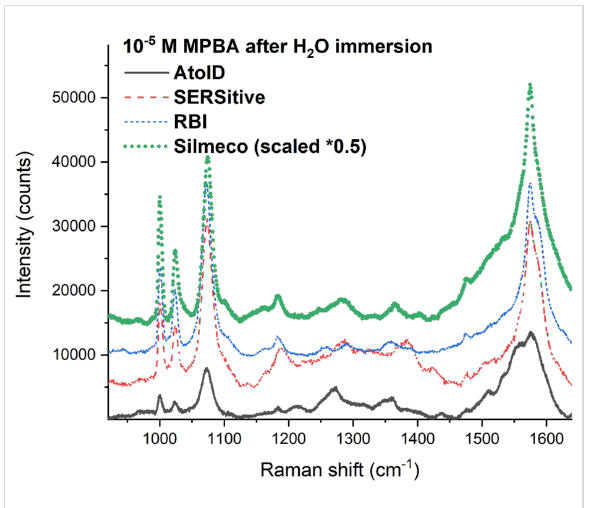
Figure 10: Comparison of the commercial SERS substrates and the synthetized sample (RBI) after the immersion in water.